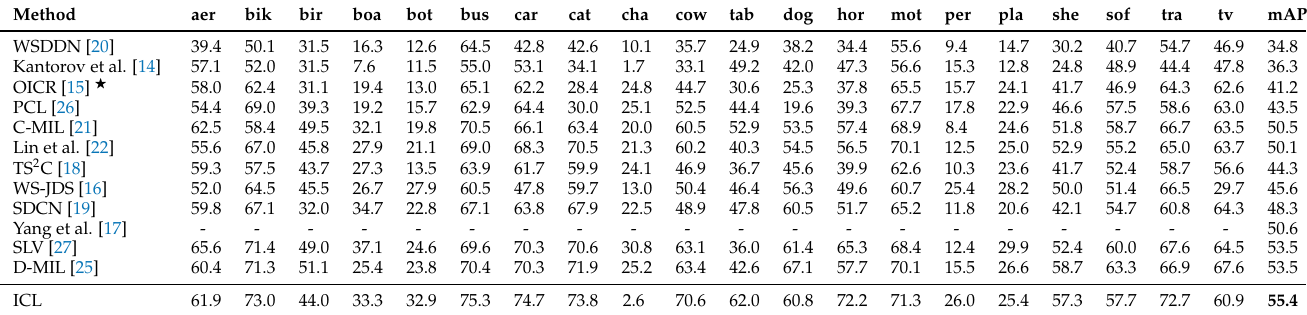
Table 1. Comparison with other methods on Pascal VOC2007 test set. (cid:70) means our baseline.